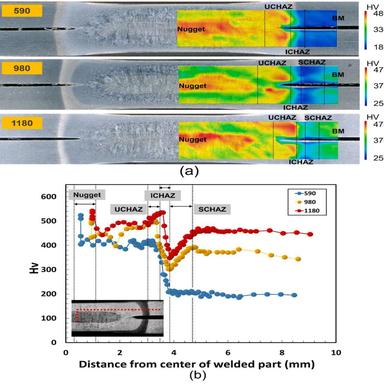
Hardness measurements of spot-welded DP590, DP980, and DP1180. (a) Hardness mapping on cross section of etched DP steel by micro hardness testing, (b) intensive hardness distribution on linear path by nano-indentation.